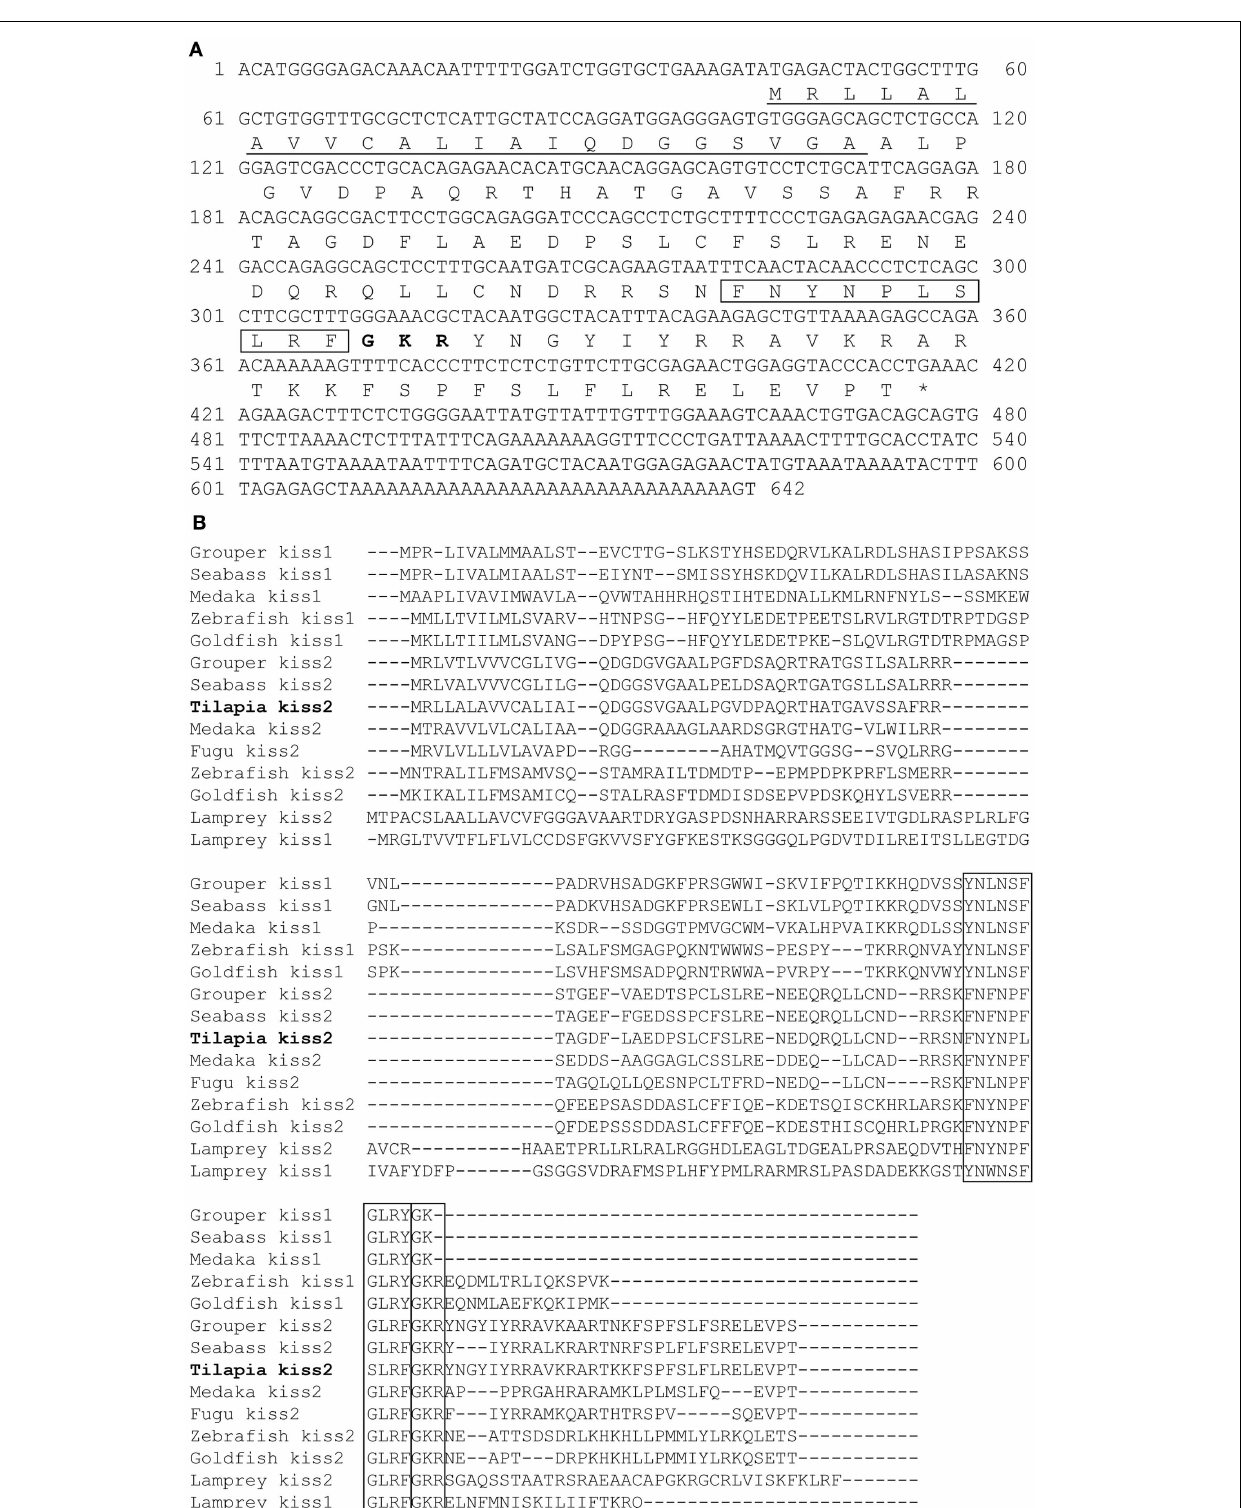
FIGURE 1 | cDNA and deduced amino acid sequence of tilapia kiss2 . (A) Nucleotide and deduced amino acid sequence of tilapia kiss2 . Putative signal peptide (underlined) were predicted using SignalP 3.0 (http://www. cbs.dtu.dk/services/SignalP/). Putative core peptide is boxed. Potential cleavage amidation site (GKR) is bolded.The stop codon is denoted by an